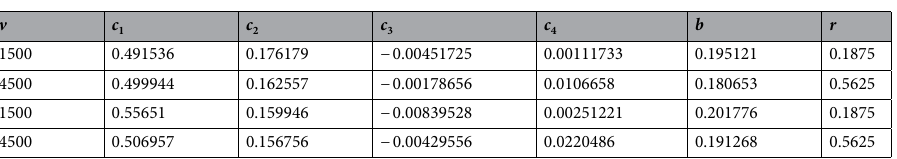
Table 1. The implicit SGFD coefficients used to obtain the dispersion error curves in Fig. 1. The first and second rows are the implicit SGFD coefficients used for Fig. 1a,b. The third and fourth rows are the HEI-SGFD coefficients used for Fig.